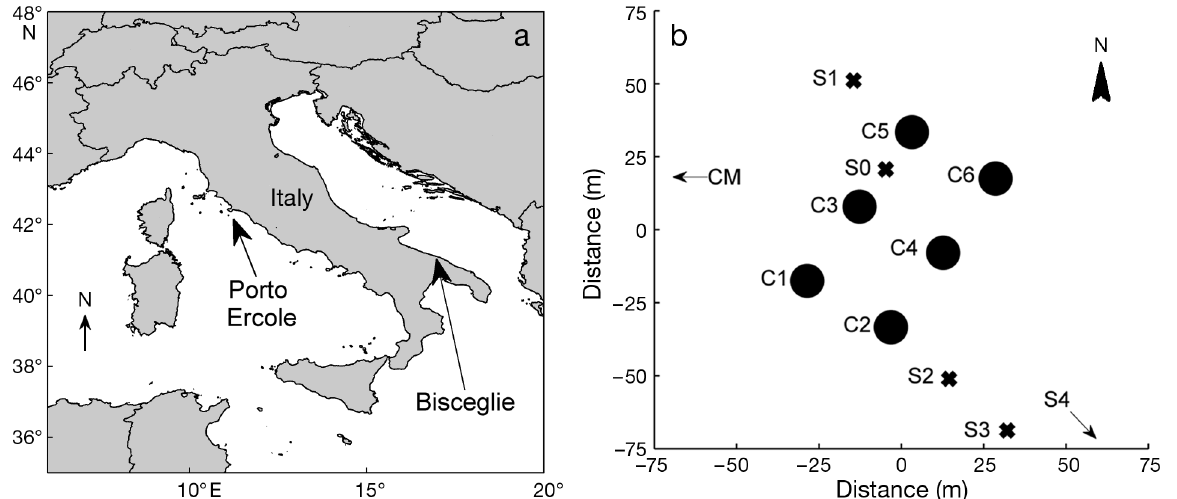
Fig. 1. (a) Location of the 2 fish farms studied in this work: the seabass Dicentrarchus labrax growth model was calibrated in Porto Ercole, and tested at both sites; the integrated model was tested in Bisceglie. (b) Layout of the Bisceglie cage module, where spatially explicit simulations were carried out. C x : cages; S x : sampling stations; S4: reference station, located 900 m from cages; CM: current meter, located 300 m from